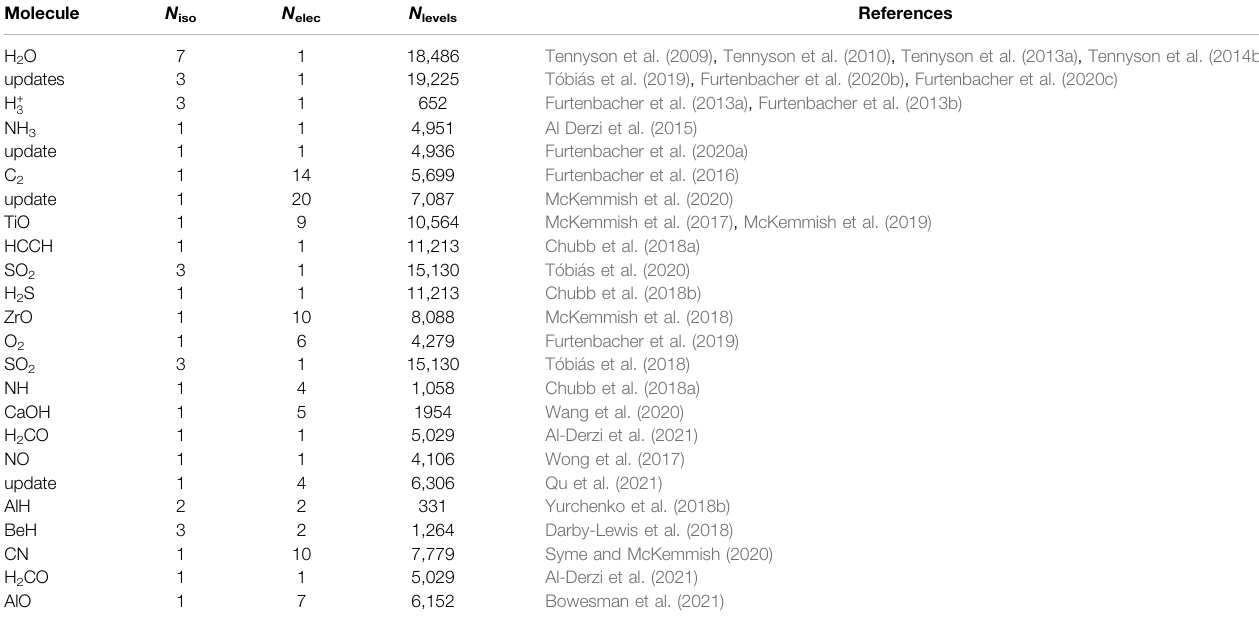
TABLE 1 | Astronomically important molecules with published MARVEL datasets.